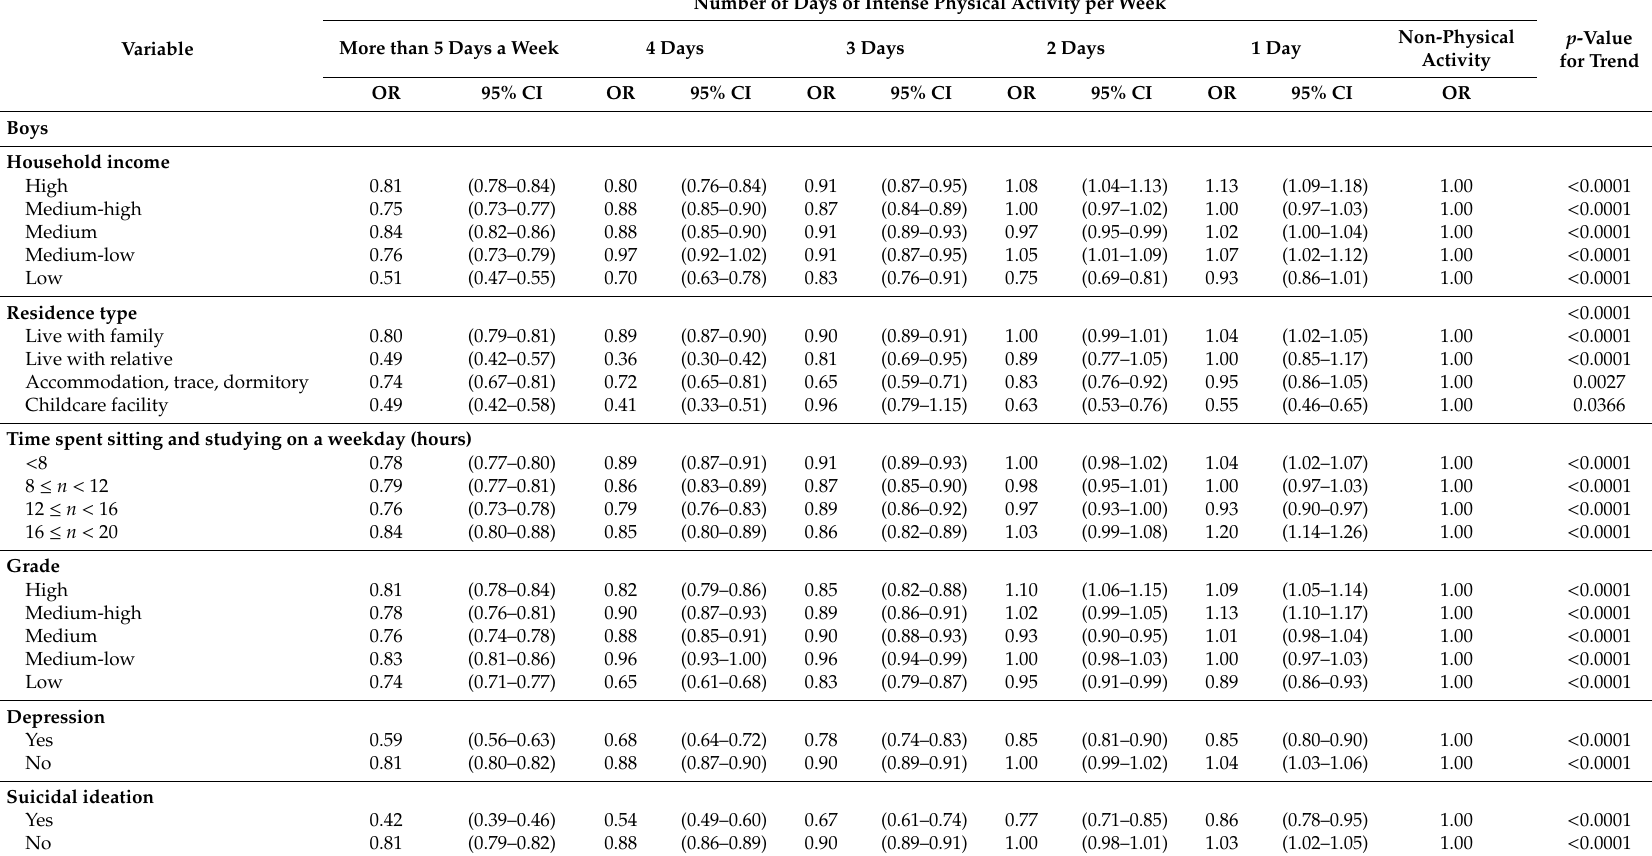
Table 3. Subgroup analysis of the association between intense physical activity and stress stratified by household income, residence type, time spent and studying for a weekday, grade, depression, and suicidal